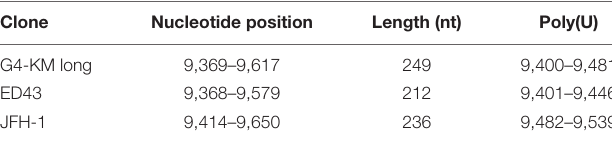
TABLE 2 | Comparison of 3 (cid:48) UTR of G4-KM long with that of other HCV infectious clones. Clone Nucleotide position Length